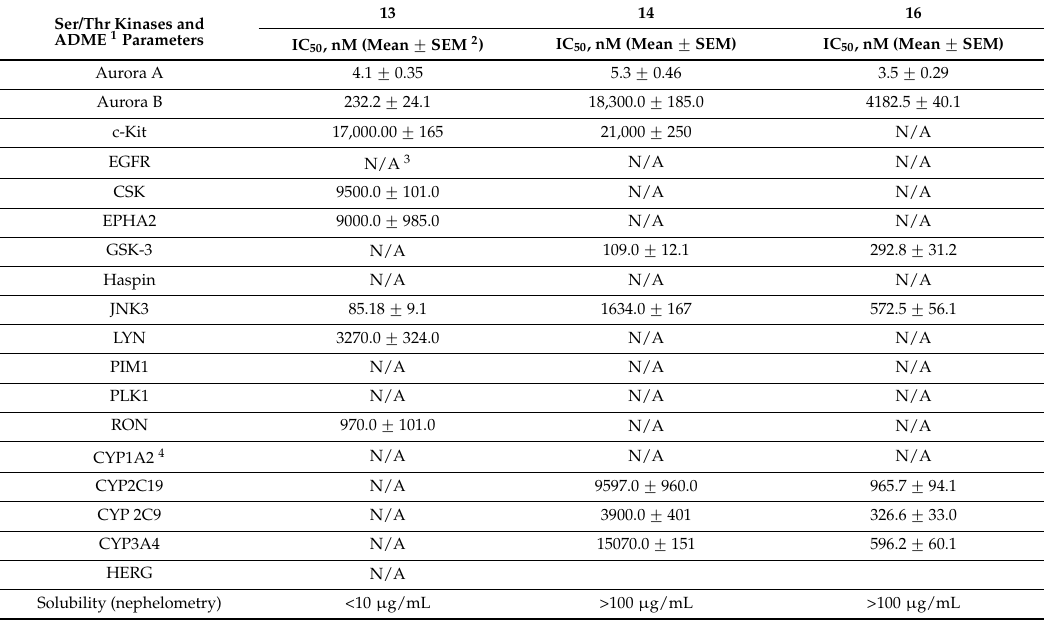
Table 3. Selectivity and some ADME properties for compounds 13 , 14 and 16 .